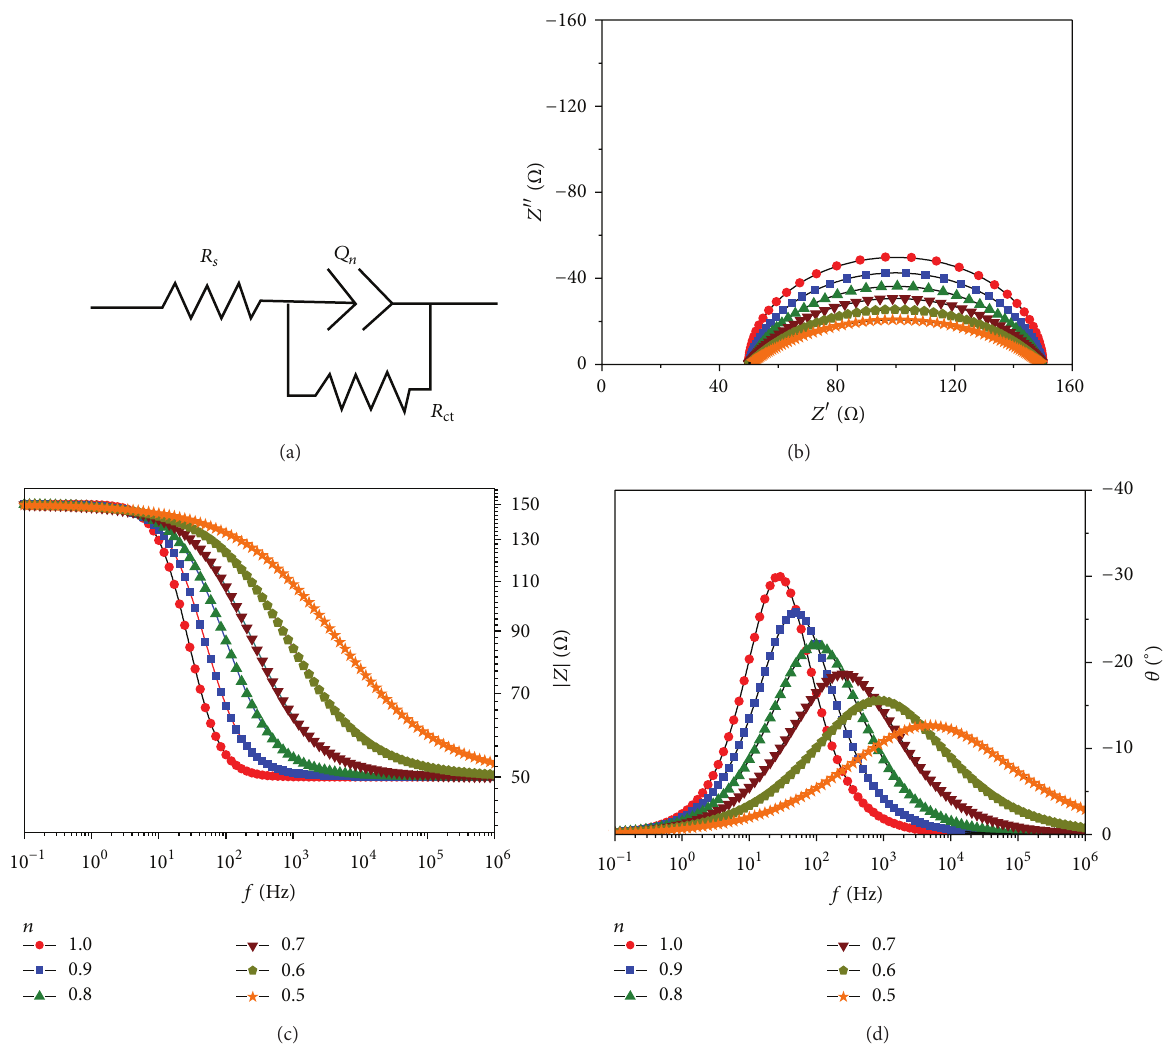
Figure 6: (a) Equivalent circuit with 𝑄 𝑛 as CPE. (b) Complex plane, (c) Bode magnitude, and (d) phase plot for the impedance corresponding = 100 Ω , and 𝑄 = 100 𝜇 F ⋅ s 𝑛−1 and different values of CPE index 𝑛 as to the equivalent circuit with 𝑅 𝑠 = 50Ω , 𝑅 𝑛 ct